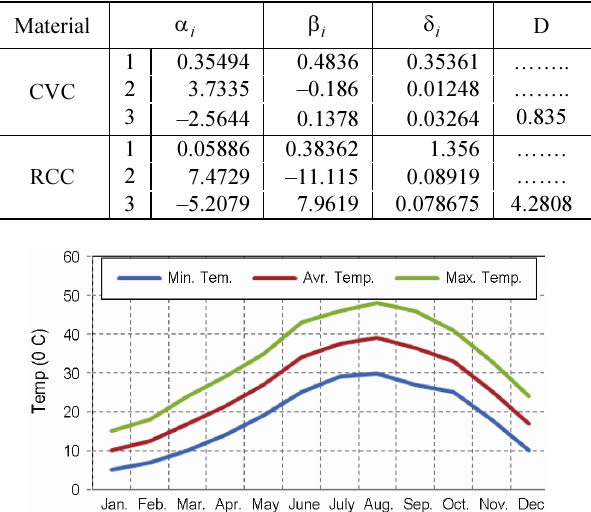
Table 2. Thermal and mechanical properties for Karun III con-